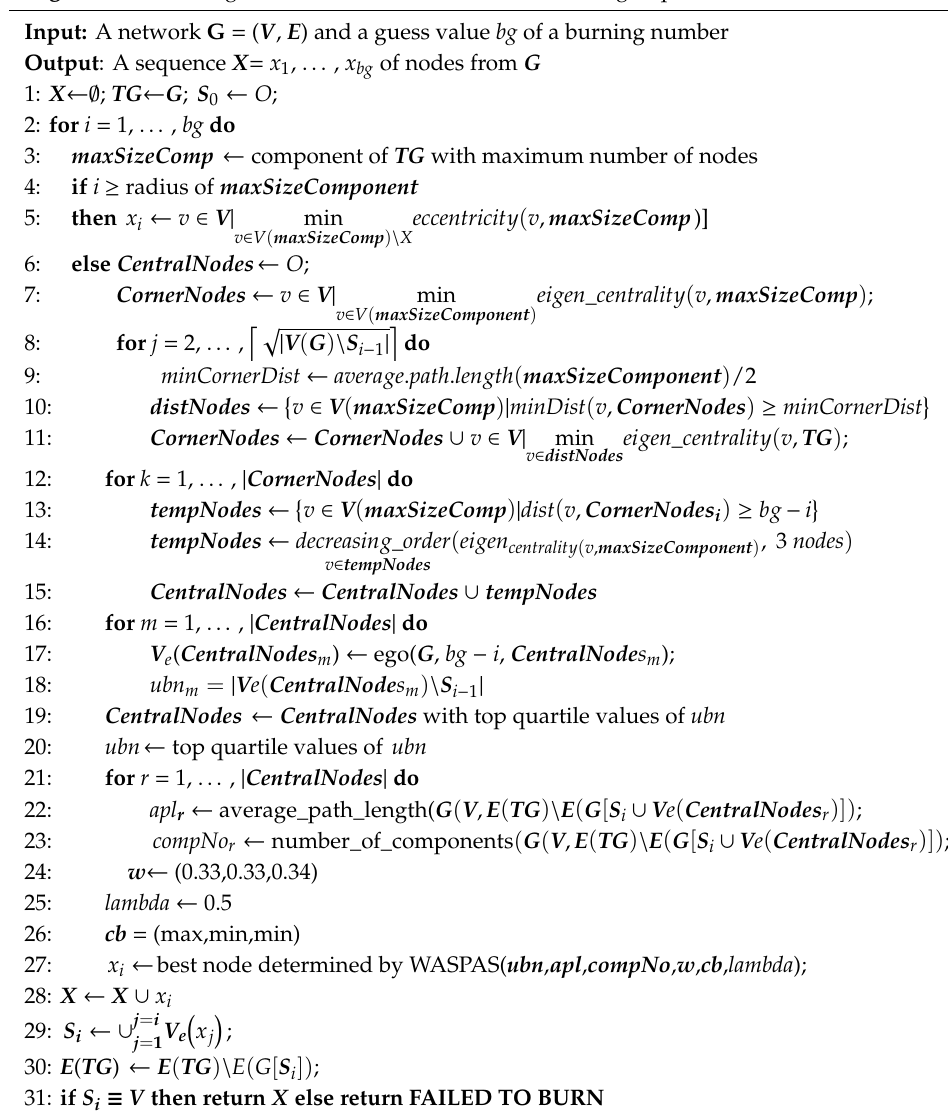
Algorithm 2. Cutting corners heuristic for a shortest burning